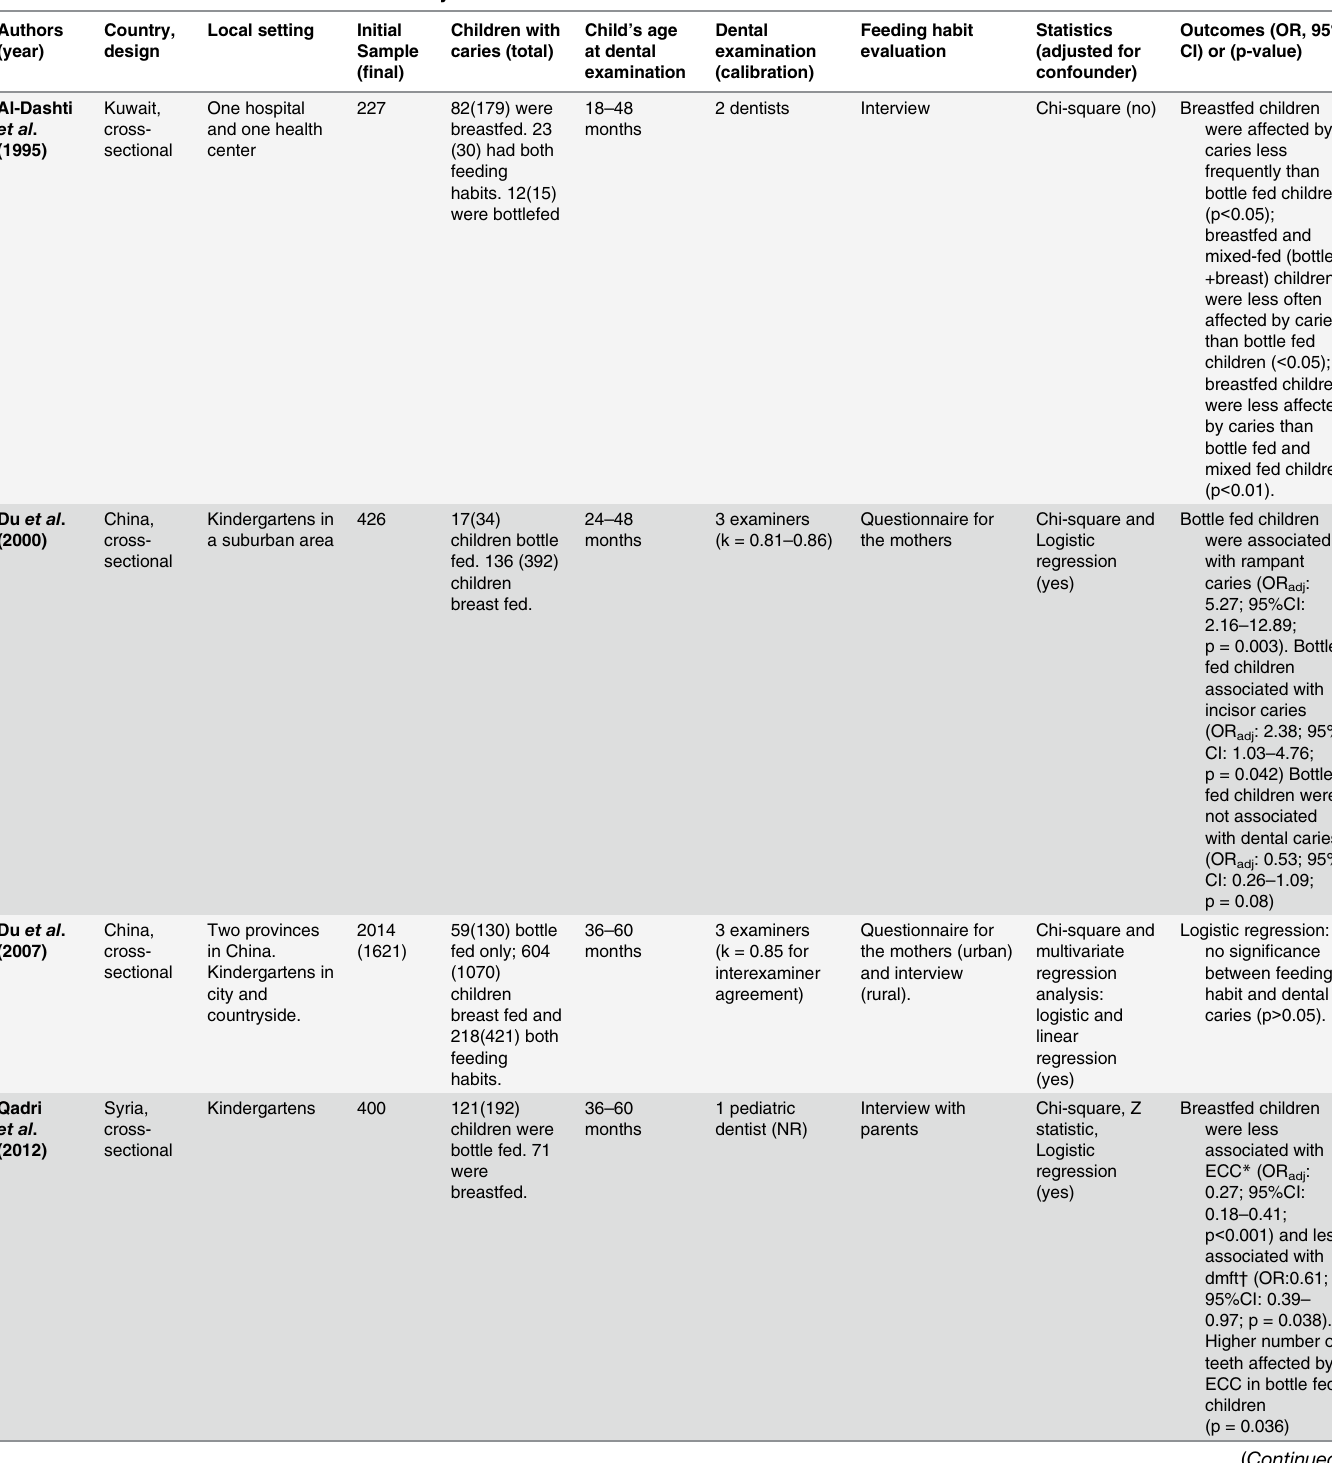
Table 1. Characteristics of studies included in systematic